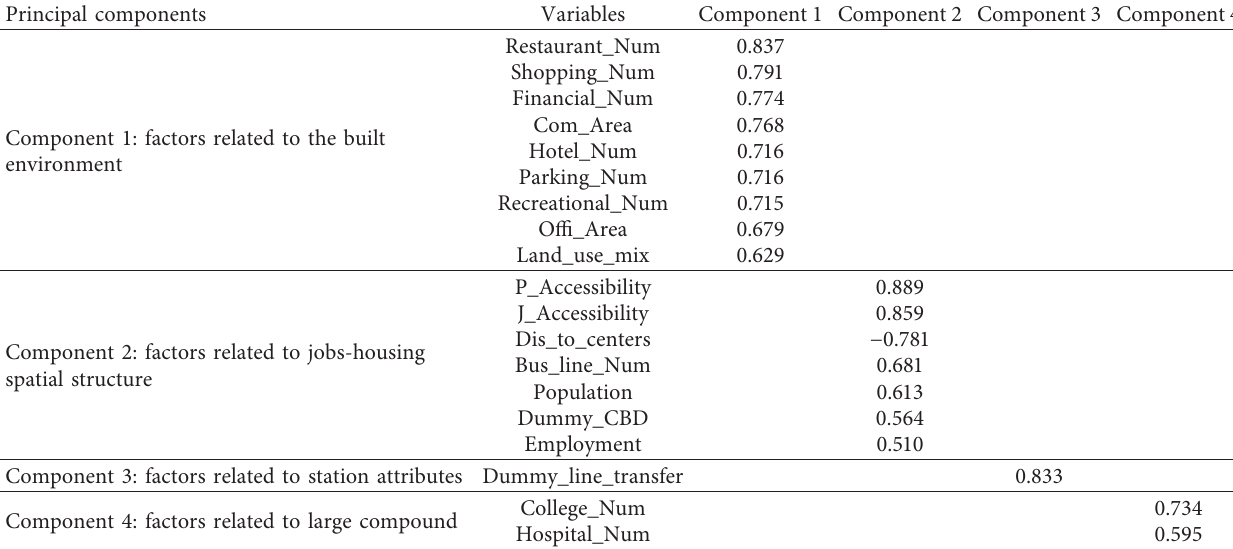
Table 5: Eigenvectors of the principal components ∗ and the correlation matrix. Principal components